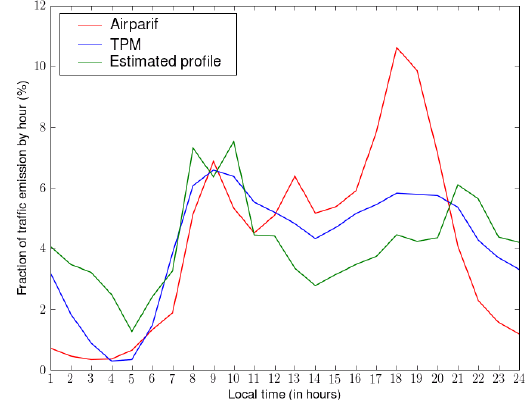
Fig. 7. Temporal profiles of traffic emissions from the Airparif inventory, from Menut et al. (2012) (TPM) and from matching EC observations at the LHVP station (Estimated